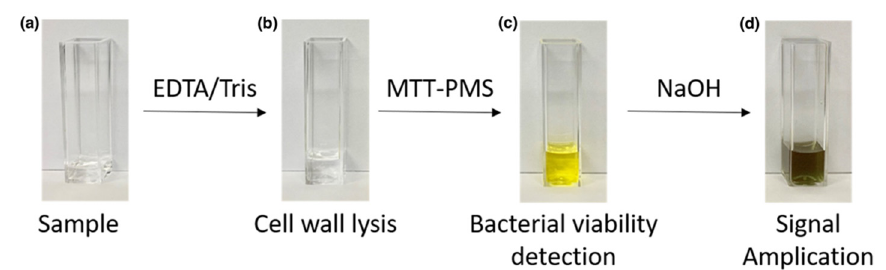
Figure 2. Sequential color changes associated with the 3-(4,5-dimethylthiazol-2-yl)-2,5-diphenyltetrazolium bromide-phenazine methosulfate (MTT-PMS) assay: ( a ) Bacterial samples were prepared using a buffer system; ( b ) EDTA/Tris was added for cell wall lysis. ( c ) MTT-PMS was added to the solution. The lightly-colored tetrazolium salt was reduced to an intensely purple formazan form. ( d ) NaOH was added for reaction amplification.